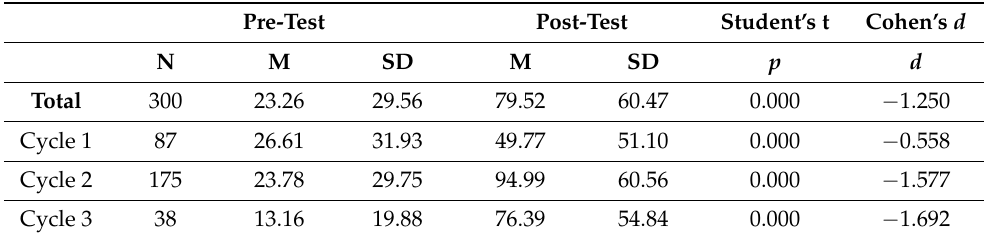
Table 2. Comparison of S1* and S5* averages by high HRV and cycles. Pre-Test Post-Test Student’s t Cohen’s d